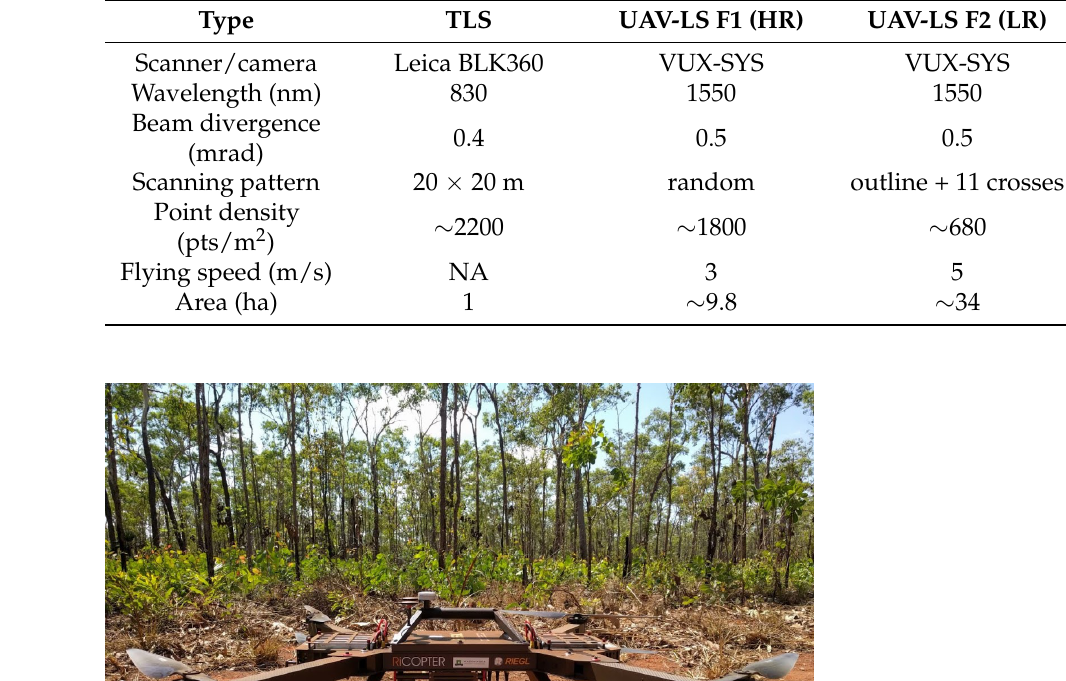
Table 1. Specifications of the three data sets.